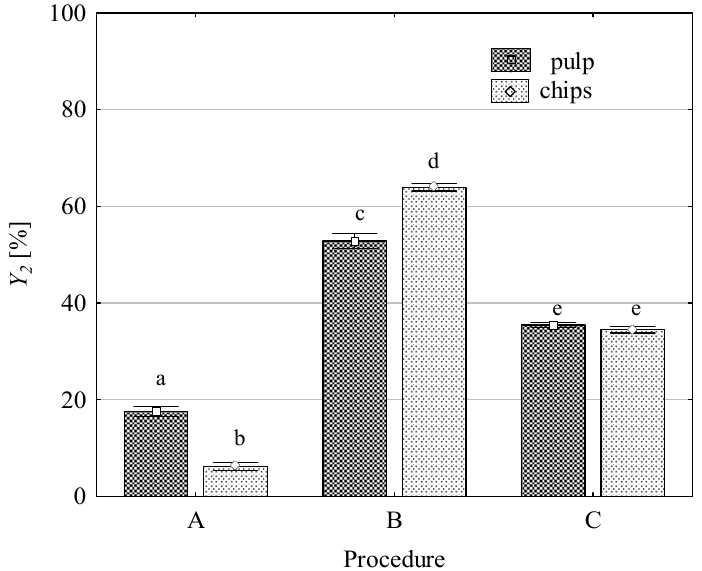
Figure 5. Impact of applied procedures on yield Y 2 in the second pressing cycle of pomace. Abbreviations, as in Figure 3. a, b, c, d, and e—average values marked with the same letter show no statistically significant difference ( p ≤ 0.05).